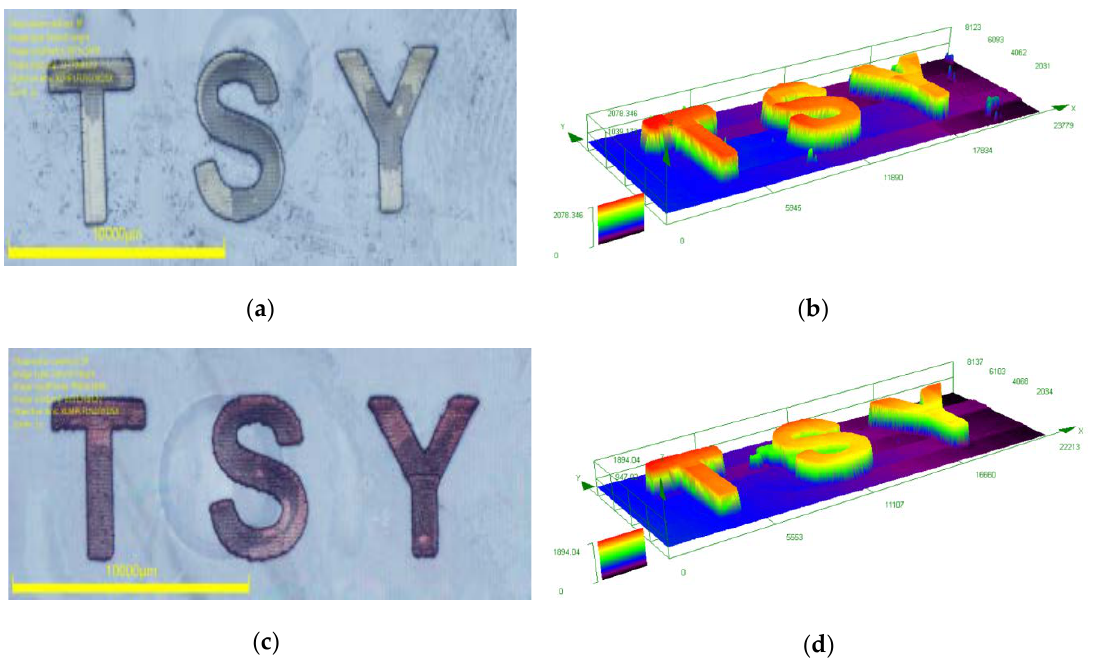
Figure 11. Free radical photopolymerization experiments for laser write experiments for different dye-based three-component photoinitiating systems in Ebecryl 40. Characterization of the 3D patterns by numerical optical microscopy: (left) top surface morphology (right) 3-D overall appearance of the 3D pattern using dye/Iod/amine (0.1%/2%/2% w/w/w) in Ebecryl 40: ( a ) ( b ) for dye 5 /Iod/EDB; ( c ) ( d ) for dye 19 /Iod/EDB.